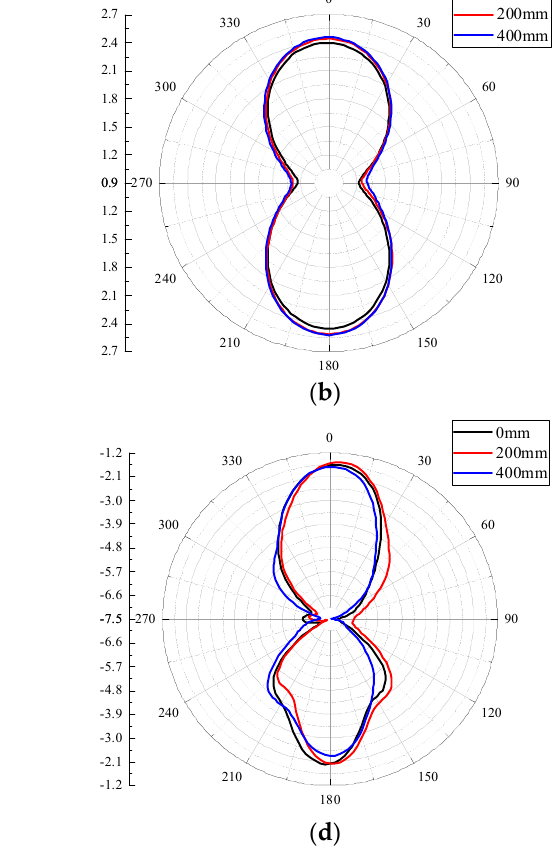
Figure 11. H-plane patterns at different frequencies: ( a ) 0.5 GHz; ( b ) 0.7 GHz; ( c ) 1 GHz; ( d ) 1.5